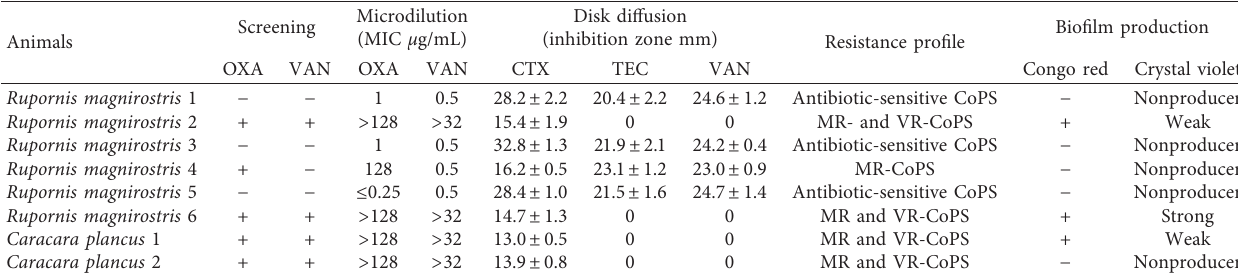
Table 1: Resistance profile and biofilm production of coagulase-positive staphylococci isolated from oropharynx of Rupornis magnirostris and Caracara plancus .